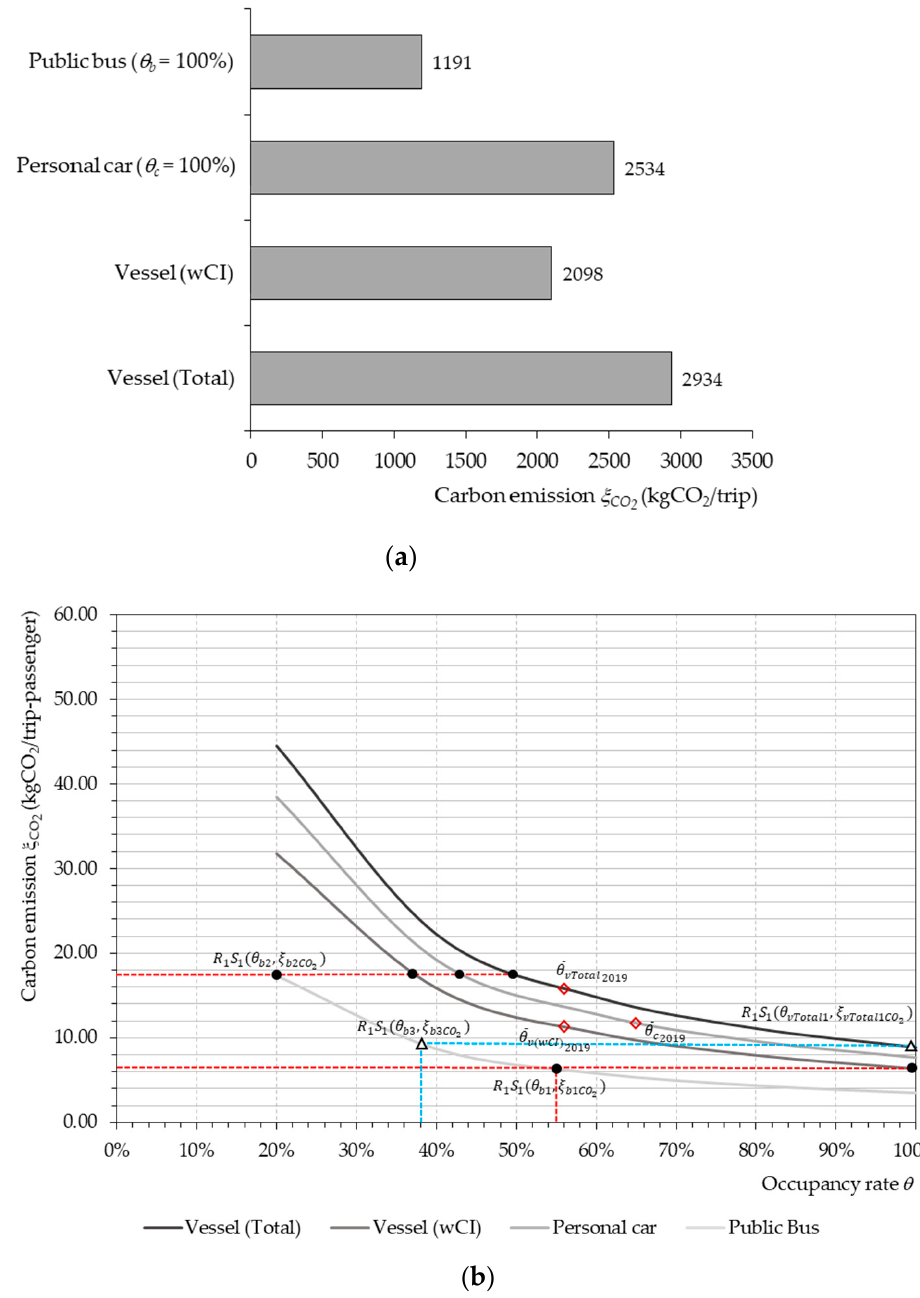
Figure 8. Calculated carbon emissions on the route segment 𝑅 (cid:2869) 𝑆 (cid:2869) : ( a ) total carbon emissions per single trip with respect to each transportation mode and based on the reference capacity of 330 pas ‐ sengers; ( b ) comparison of carbon emissions with respect to the 𝜃 for each transportation mode